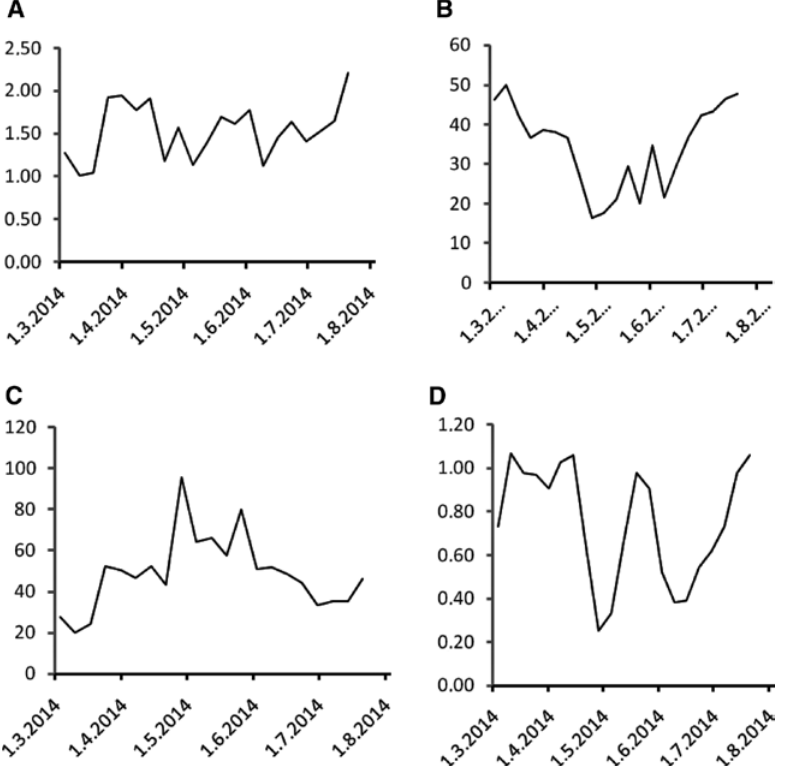
Figure 2: Kynurenine, tryptophan and retinol during the course of treatment. (A) Serum kynurenine concentrations (in μ mol/L), (B) serum tryptophan concentrations (in μ mol/L), (C) serum kynurenine/tryptophan ratios (in mmol/mol) and (D) serum retinol concentrations (in μ mol/L) measured in weekly intervals during the course of